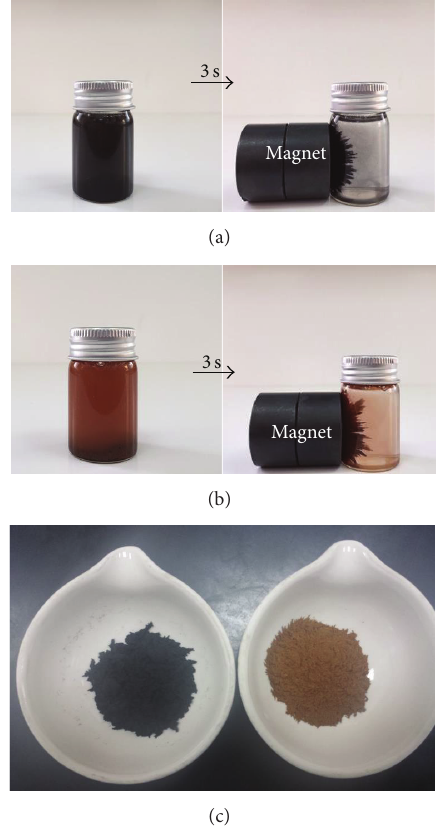
Figure 1: Photographs of aqueous solutions of F 3 O 4 nanoparticles (a), Ag-Fe 3 O 4 nanoparticles in a vial (b) before and after being separated from solution using an external magnet for 3 s, and (c) the dried fabricated